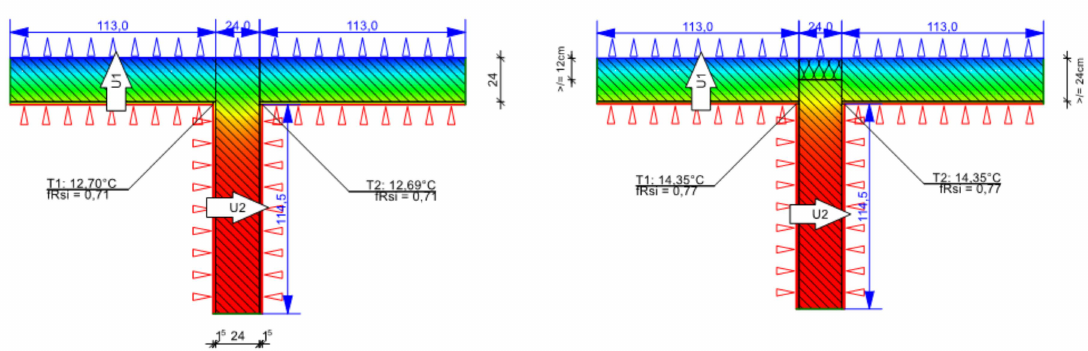
Figure A6. Before and after the thermal bridge retrofit of an inside wall (created with ThermCad thermal bridge simula- tion